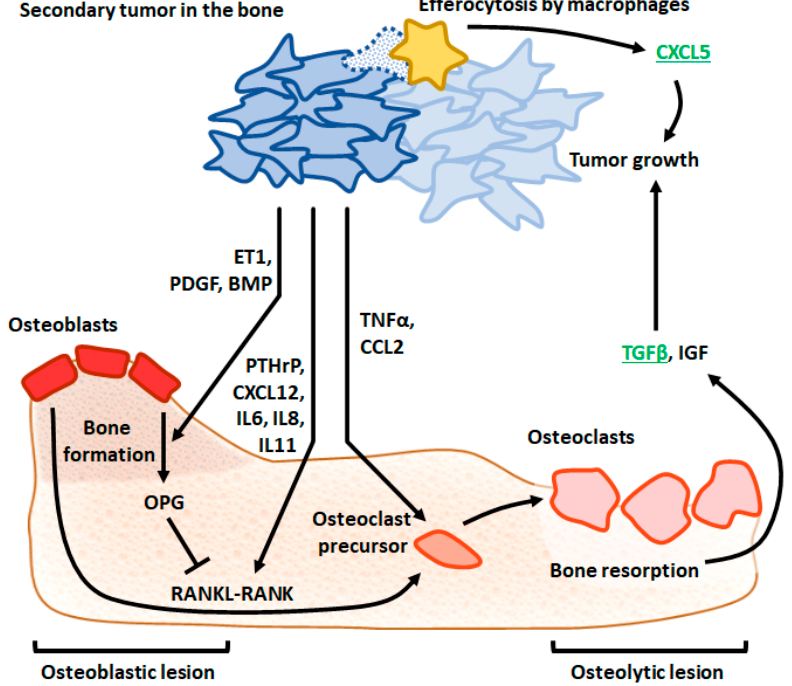
Figure 3. The vicious cycle of bone remodeling and tumor growth in bone metastasis [45,46]; cytokines confirmed to mediate this mechanism in the spine (CCL5 and TGF β ) are indicated in green. BMP, bone morphogenetic protein, CCL, CC motif chemokine ligand, CXCL, CXC motif chemokine ligand, ET, endothelin, IGF, insulin-like growth factor, IL, interleukin, OPG, osteoprotegerin, PDGF, platelet-derived growth factor, PTHrP, parathyroid hormone-related protein, RANK, receptor activator of nuclear factor- κ B, RANKL, receptor activator of nuclear factor- κ B ligand, TGF, transforming growth factor, TNF, tumor necrosis factor.